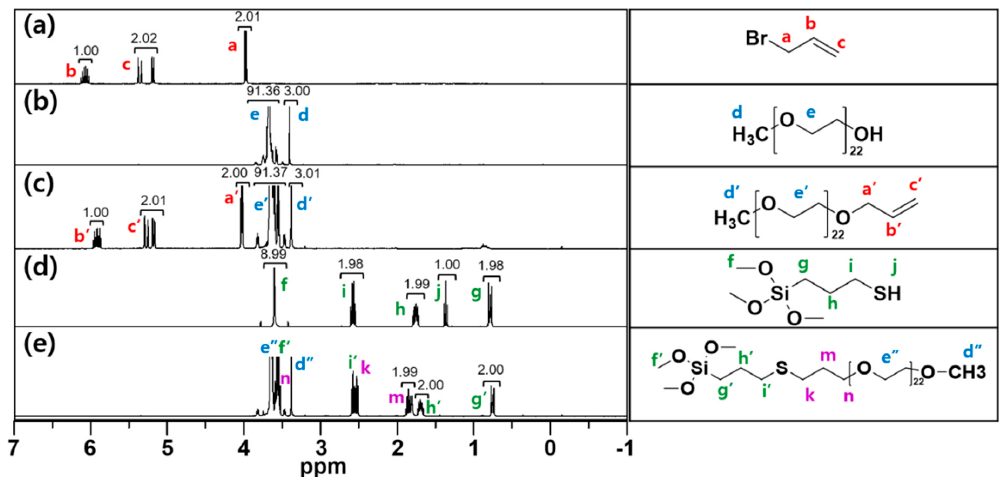
Figure 1. 1 H NMR spectra of ( a ) allyl bromide, ( b ) PEG, ( c ) polyethylene glycol monomethyl ether (MPEG), ( d ) 3-mercaptopropyltrimethoxysilane (MPTMS) and ( e ) MPEGTMS and corresponding chemical structure assignments.